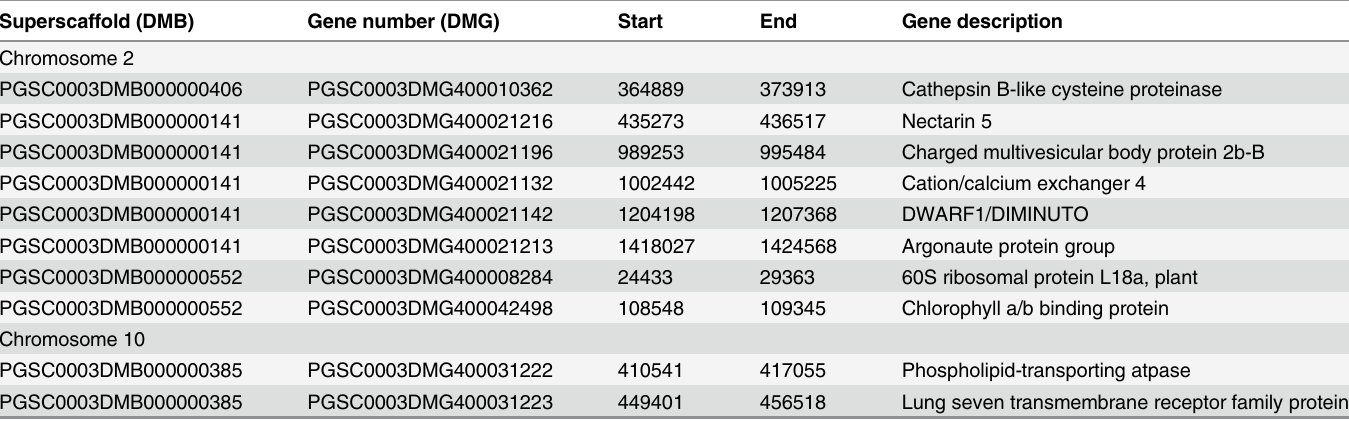
Table 1. Differentially expressed genes on three superscaffolds under the tuber shape QTLs. Superscaffold